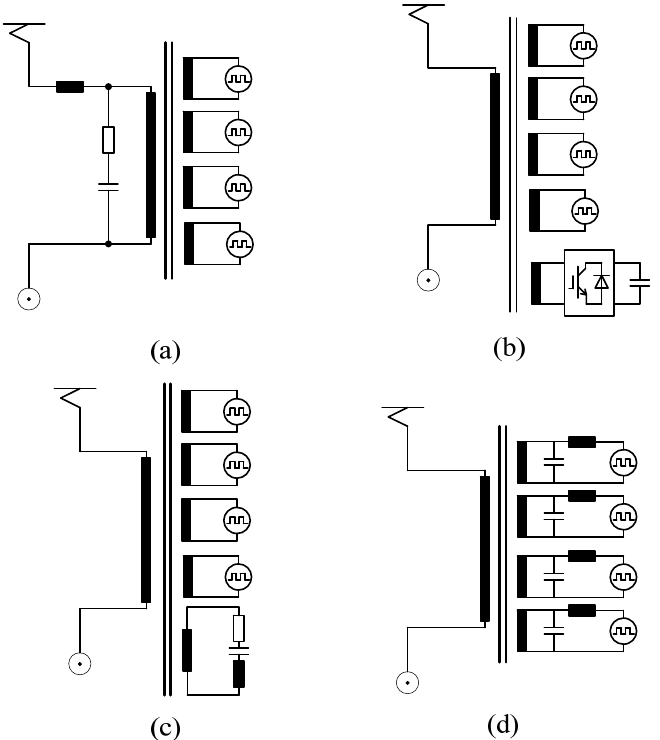
Figure 1. Harmonics compensation methods for AC locomotives: ( a ) passive harmonic filter (compensation on the high-voltage side), ( b ) active harmonic compensator, ( c ) passive harmonic filter (compensation with additional filter windings), and ( d ) LCL-type filter compensation on the low-voltage side.